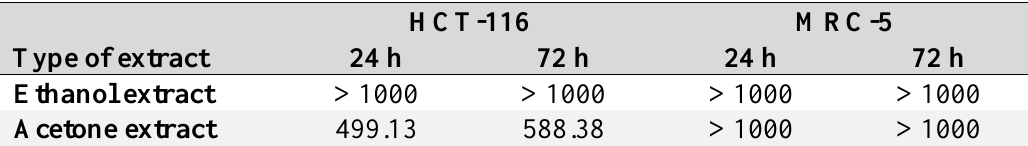
Table 8. IC values (µg/mL) of ethanol and acetone extracts of T. 50